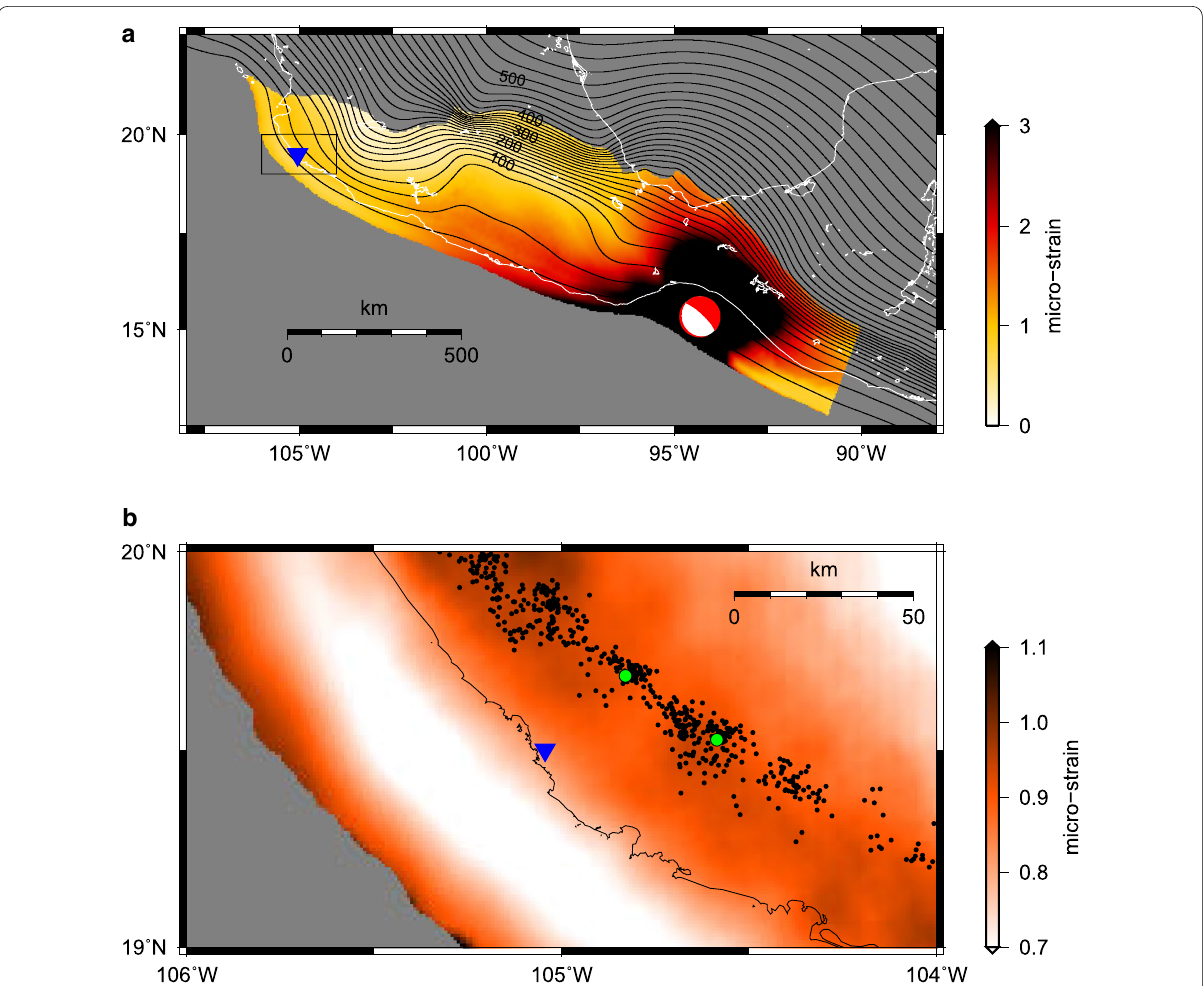
Fig. 3 Maximum magnitudes of the strain tensor eigenvalues at depths along the slab top. The contour lines in a show the depths of Slab2 and those obtained by extrapolation, in km. In the magnified map in b , the locations of tectonic tremors by Idehara et al. (2014) are indicated by black dots. Station CJIG is indicated by a blue inverse triangle. Two assumed locations of triggered tremors are indicated by green circles, where stress changes are